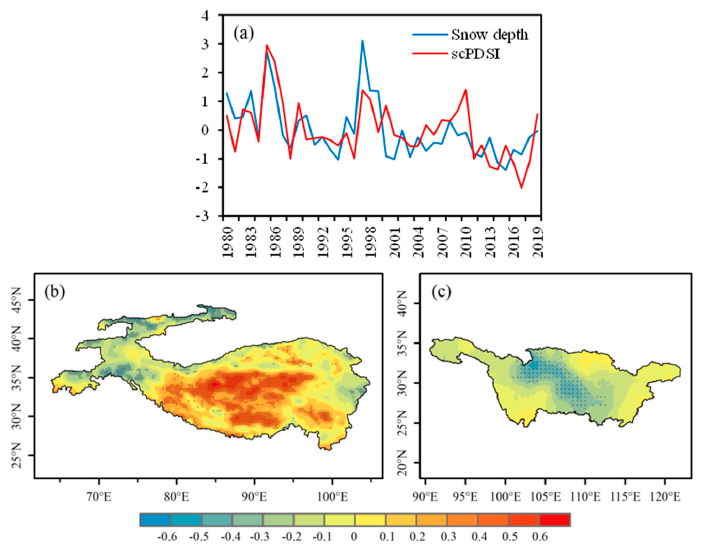
Figure 6. The spatial distributions of the left and right fields of the first SVD mode and their time series, derived from winter snow depth of HMA and the succeeding spring scPDSI of YRB during the period 1980–2019. ( a ) Normalized time series of winter snow depth (blue line) and spring scPDSI (red line)—units are arbitrary; ( b ) snow depth of HMA and ( c ) scPDSI of YRB—dotted area means passing significance test of 0.05.